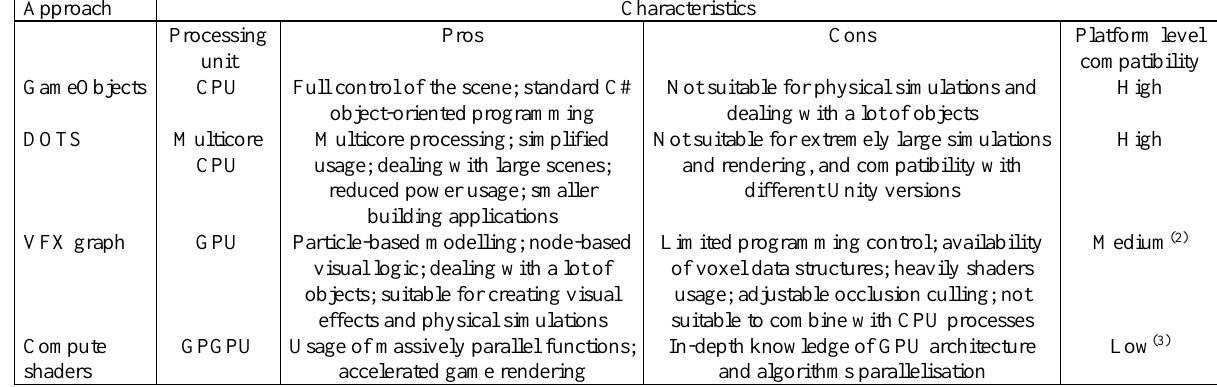
Table 1 . Voxelisation approaches and voxel data structures supported in Unity